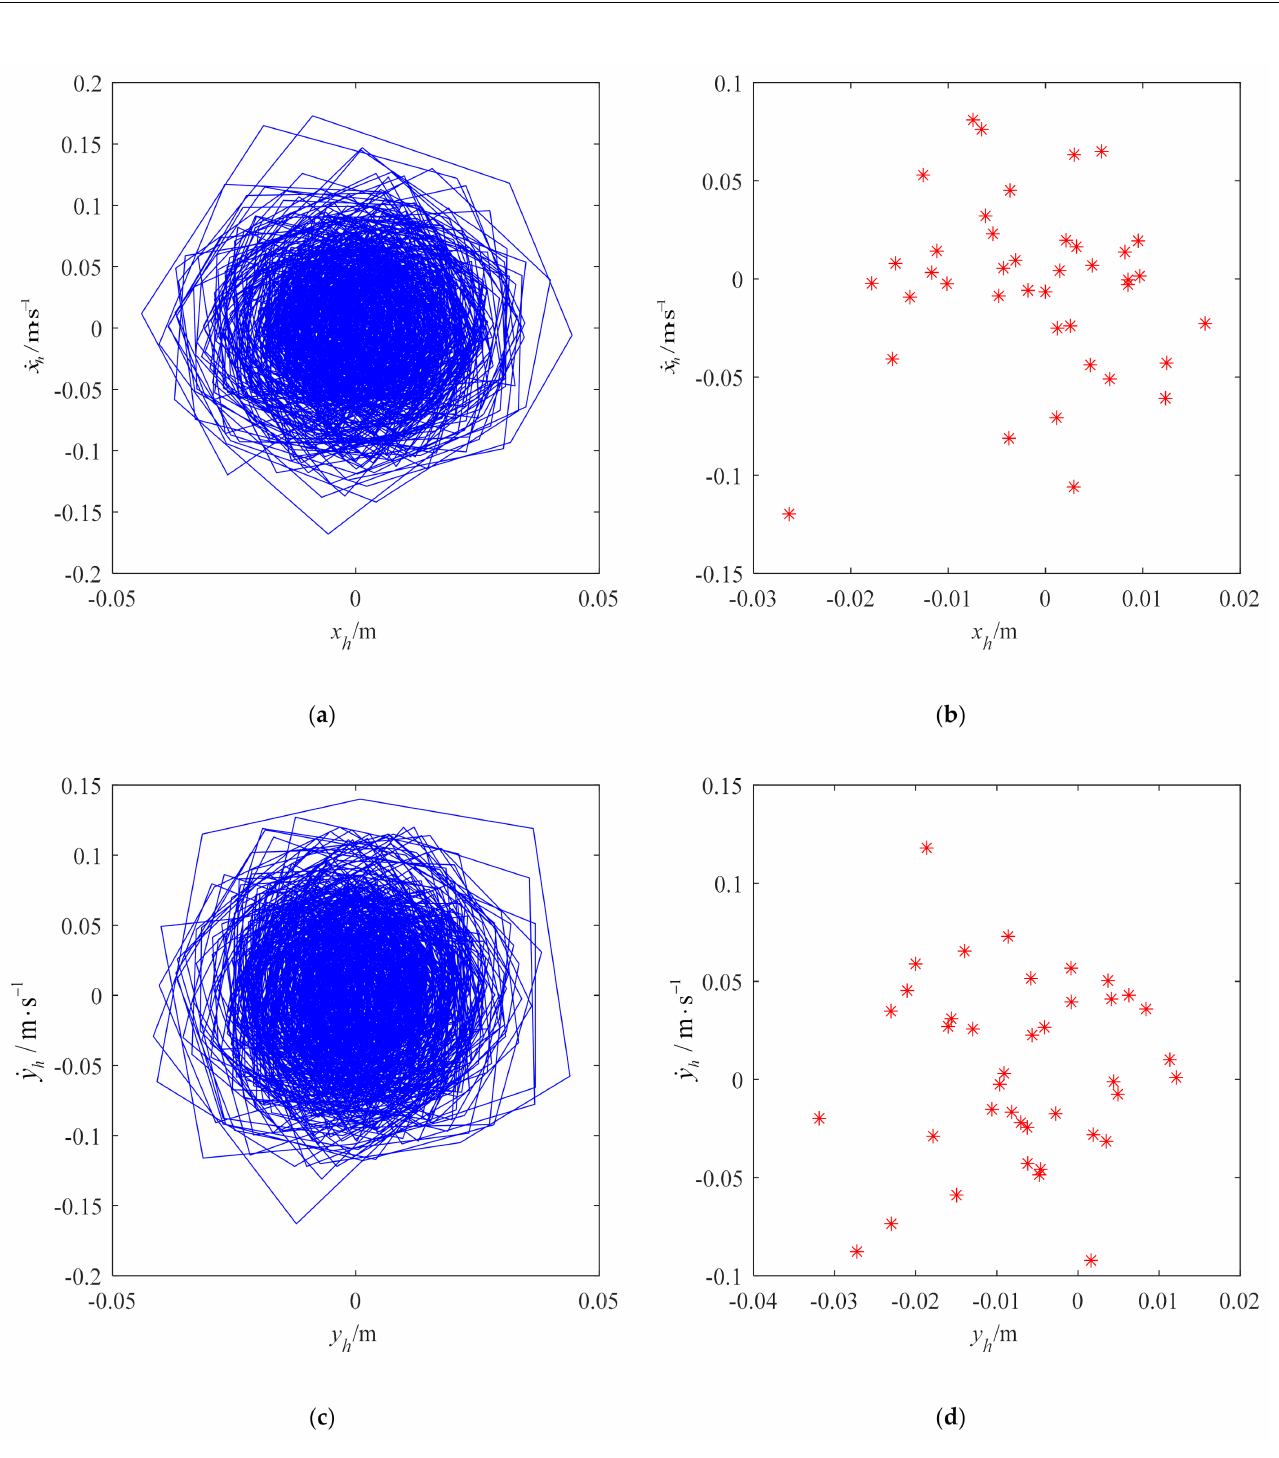
Figure 6. Vibration characteristics of the cutting head when f p = 10. ( a ) x h -direction vibration phase diagram of the cutting head, ( b ) x h -direction Poincar é section of the cutting head, ( c ) y h -direction vibration phase diagram of the cutting head, ( d ) y h -direction Poincar é section of the cutting head. Every “*” in ( b , d ) represents one cycle of vibration